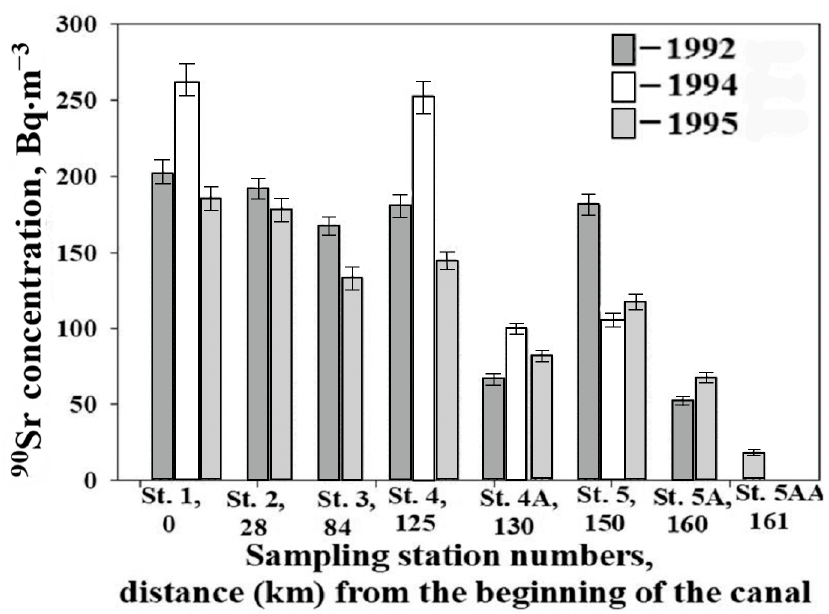
Figure 3. Dynamics of 90 Sr concentration in the NCC water in 1992–1995.